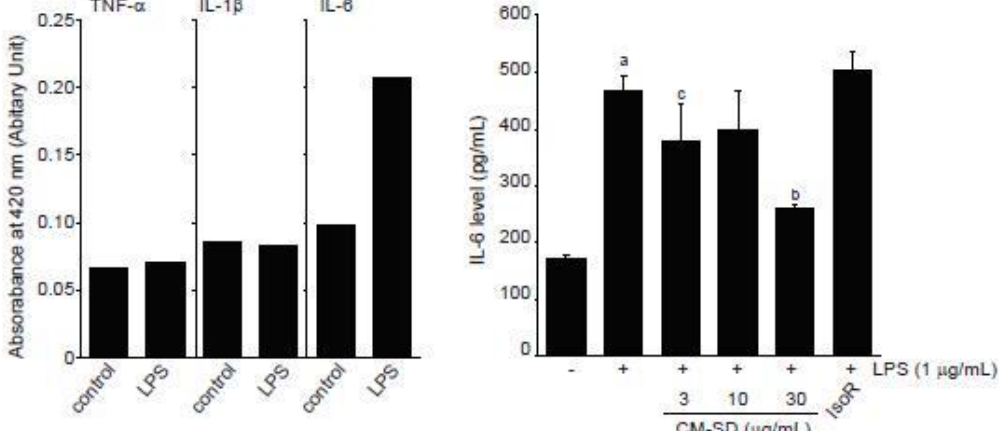
Figure 7. Effect of CM-SD on proinflammatory cytokines production. Values are expressed mean ± SD of three separate experiments. a p < 0.01, significant as compared with control by Dunnett’s T3 test; b p < 0.01, c p < 0.05, significant as compared with LPS-treated cells by Dunnett’s T3 test.